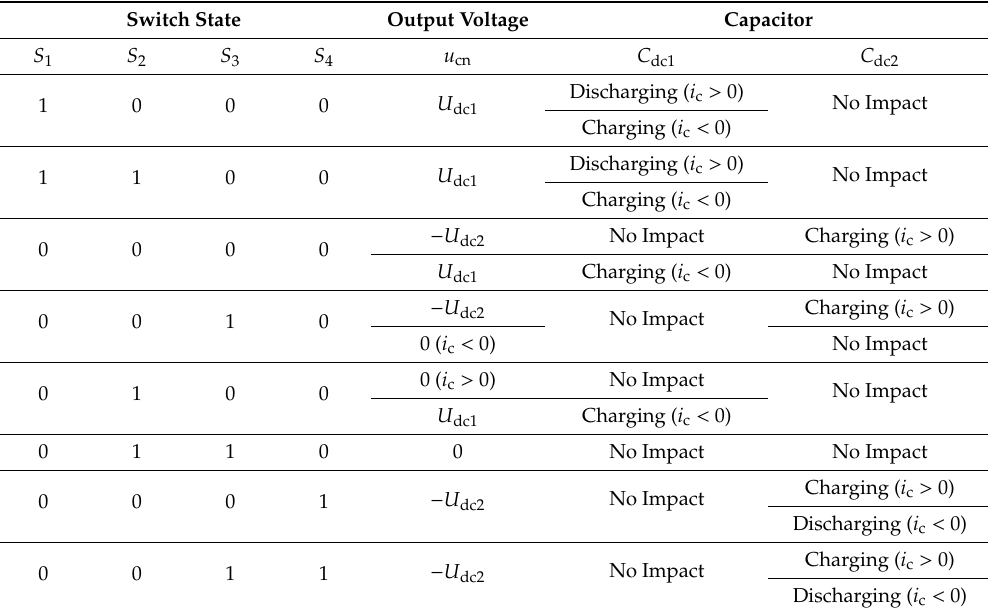
Table 3. Switch states of power router under AC